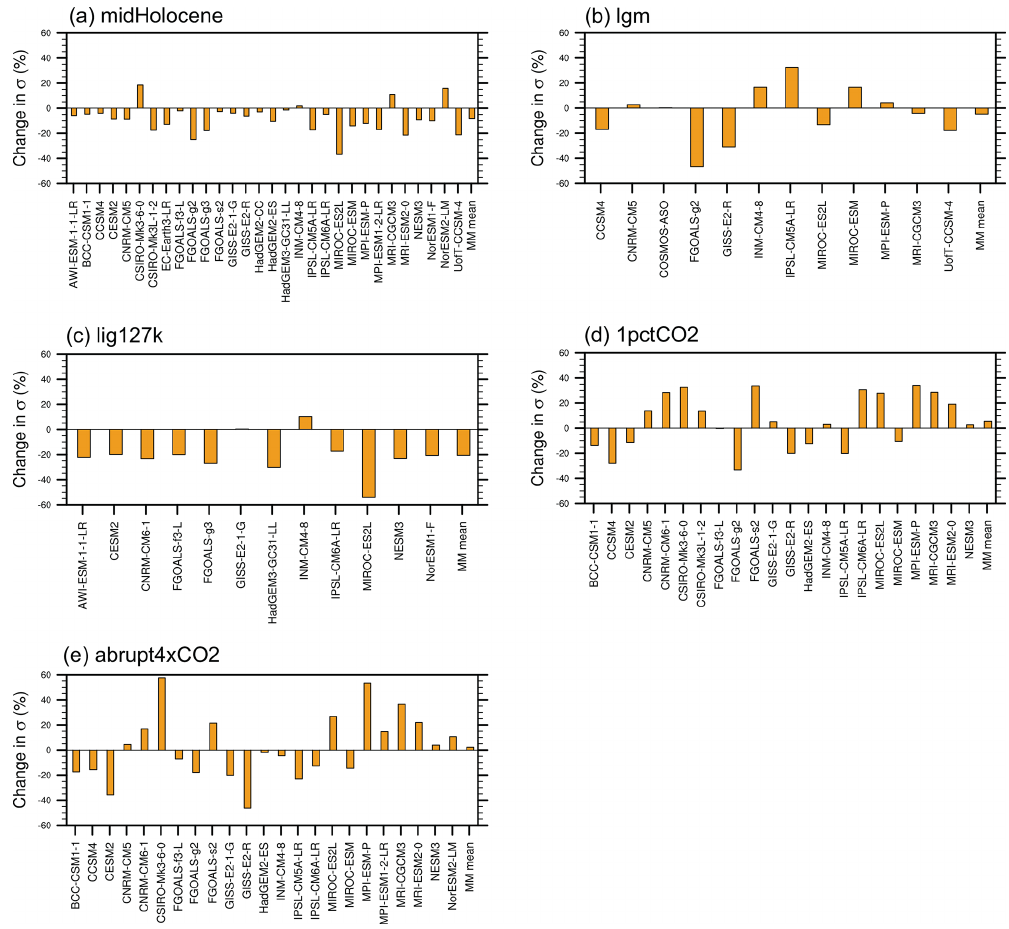
Figure 9. Change in amplitude of ENSO measured from standard deviation of NINO3.4 index relative to piControl amplitude (%) in (a) midHolocene , (b) lgm , (c) lig127k , (d) 1pctCO2 , and (e) abrupt4xCO2 . Model names are given below plots. MM mean is also